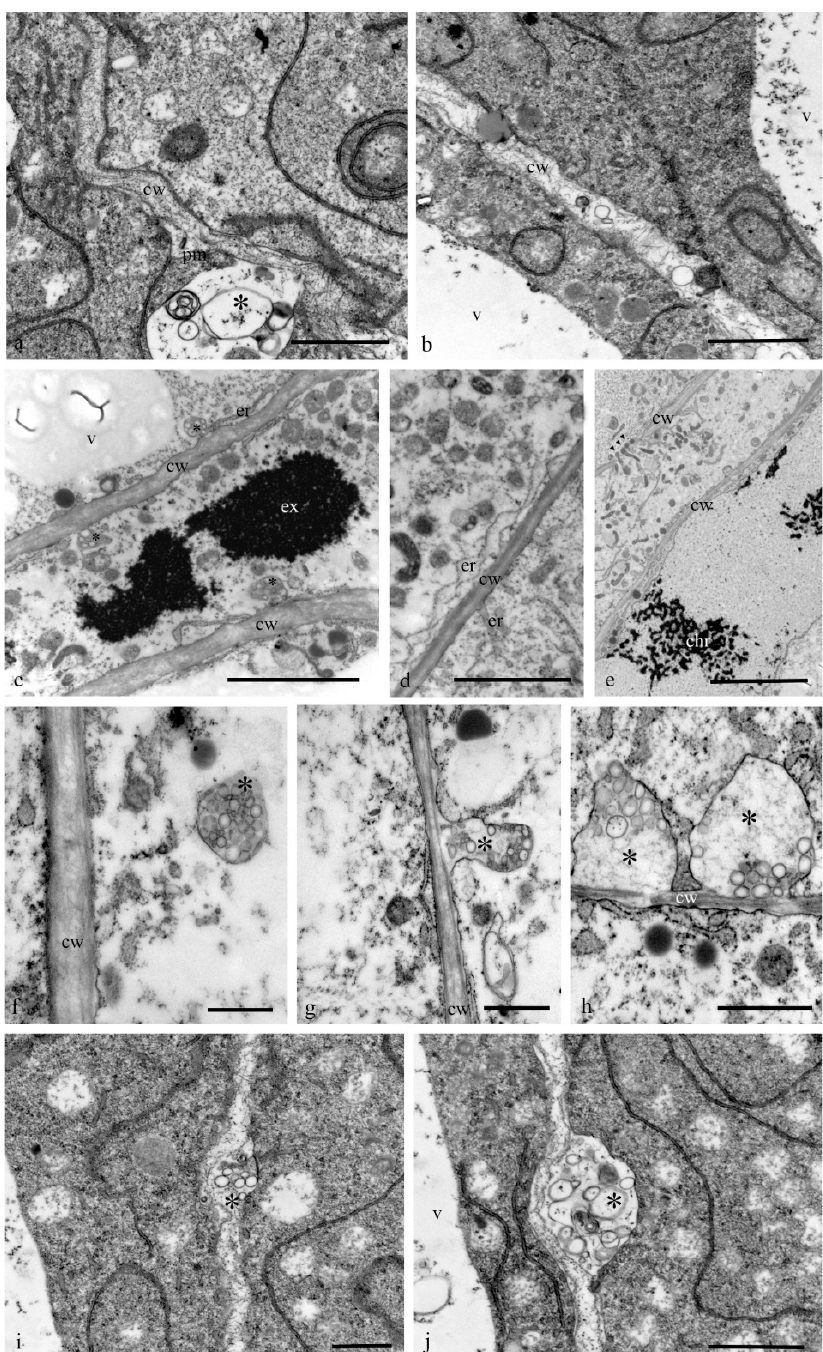
Figure 11. Ultrastructure of the cell walls and multivesicular bodies of the antipodal cells of the wheat embryo sac. The cell walls between antipodal cells have an unequal thickness and disordered hemicellulose microfibrils ( a , b ). Expanded cisternae of the granular reticulum may be observed near the plasma membrane ( c ), and the cavities of the reticulum cisternae are often fused with the plasma membrane ( d ). The transfer of various organelles from cell to cell through wide channels in the cell wall can be observed ( e ). In the cytoplasm of antipodal cells, exocytosis or endocytosis of the multivesicular bodies is evident, often combined with the plasma membrane ( f – j ). Multivesicular bodies (*) were found in the area of the cell walls. cw—cell wall; pm—plasma membrane; v—vacuoles; er—granular reticulum; ex—granular reticulum; chr—polytene chromosomes. Scale: ( a )—2 µ m; ( b – d )—5 µ m, ( e )—10 µ m, ( f )—2 µ m; ( g , h )—1 µ m, ( i , j )—2 µ